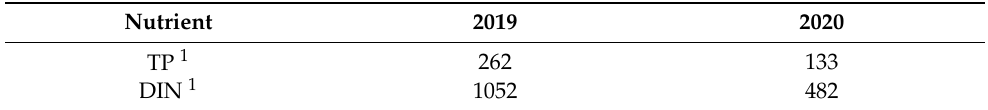
Table 8. Total annual AD nutrient loads to Utah Lake for 2019 and 2020. Nutrient